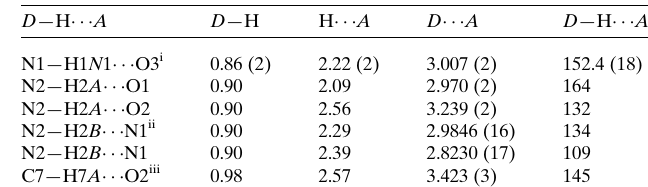
Table 1 Hydrogen-bond geometry (A˚ , (cid:4) ).